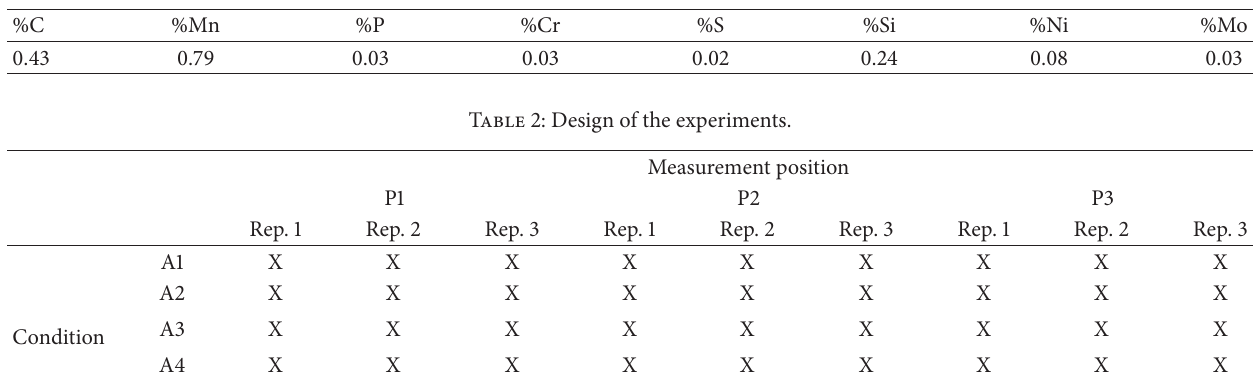
Table 1: Chemical composition of the AISI 1045 steel samples.